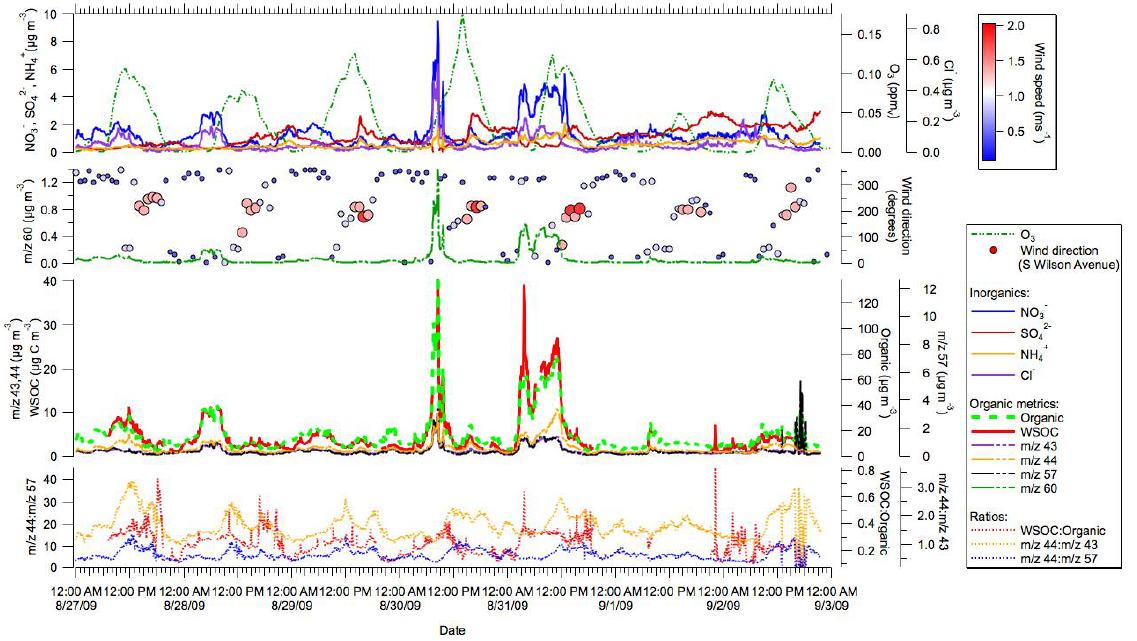
Fig. 7. Time series of various measured and derived parameters during the Station Fire period. The symbol size for wind direction is proportional to measured wind speed (South Wilson Avenue